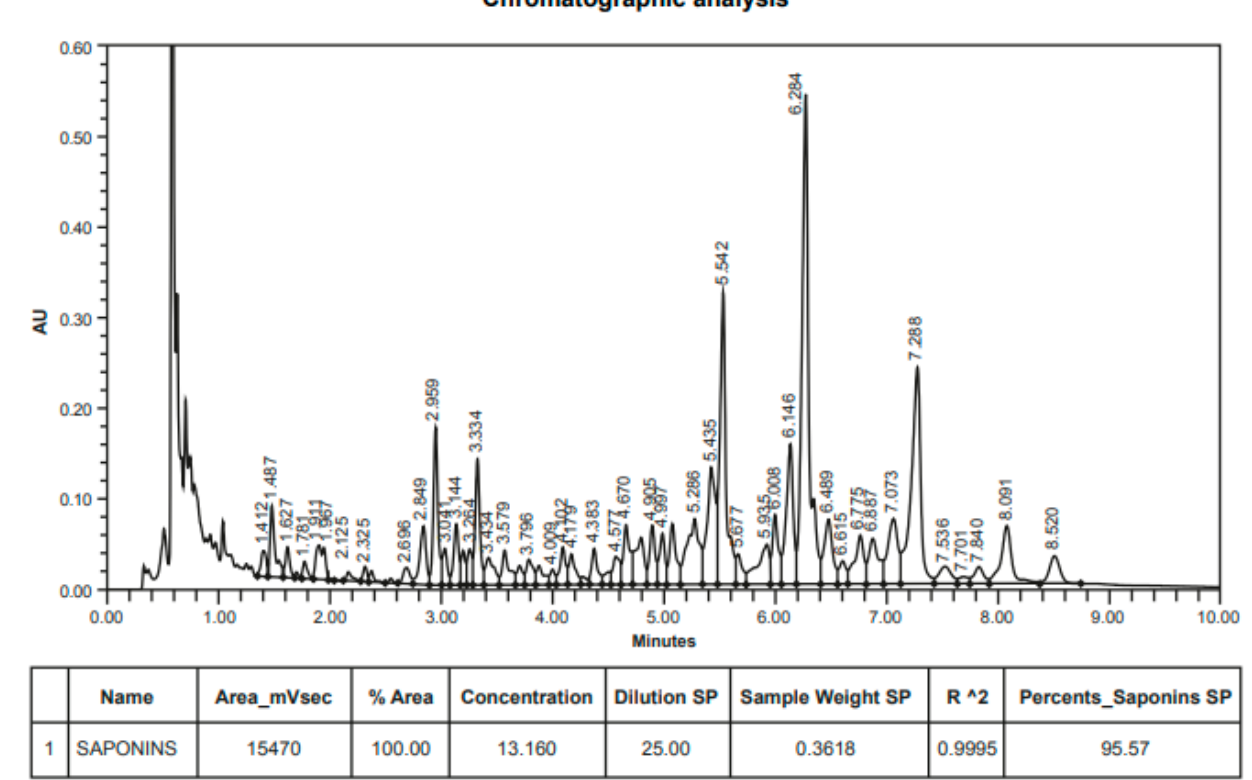
Figure 1. UHPLC of purified Quillaja saponin extract (PQSE) (96% saponins, w / w ). UHPLC of PQSE from which almost all non-saponin fraction components (phenolics, polysaccharides) have been separated.